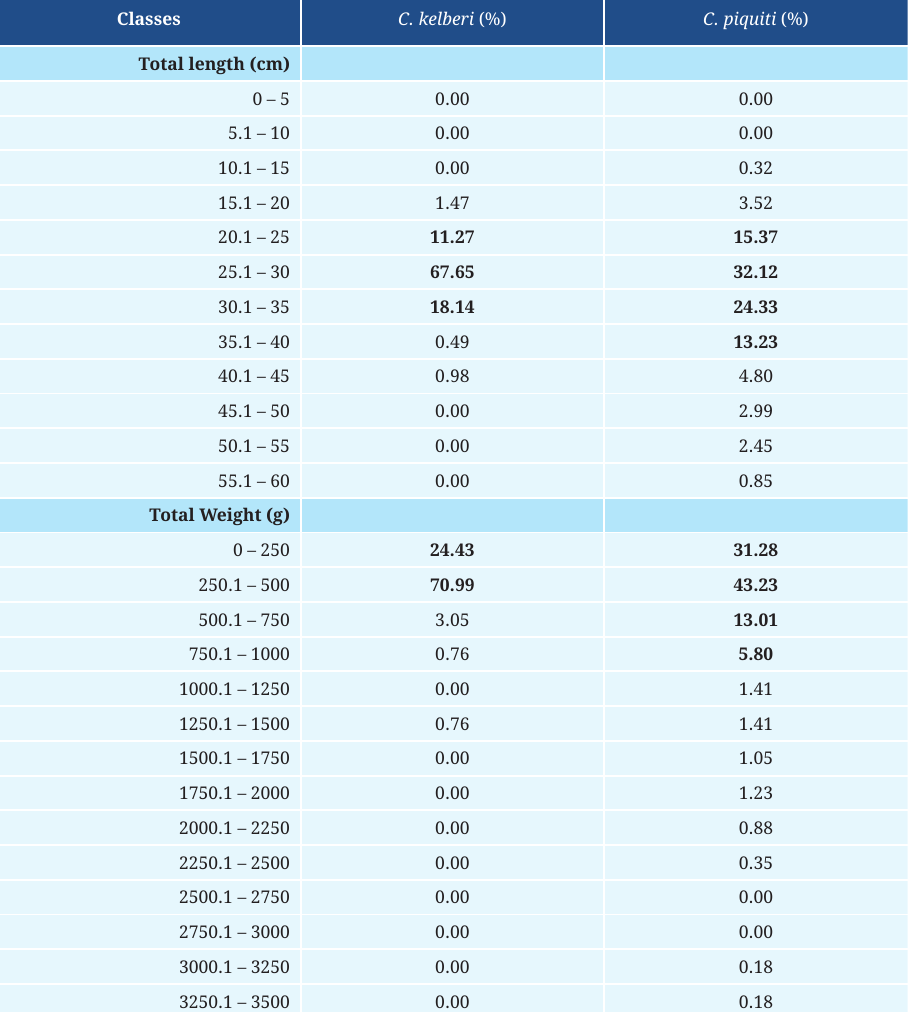
statistically clear difference in mean TL (ANOVA: Welch F = 94.0; p < 0.0001) and 1;1139 TW (ANOVA: Welch F = 35.81; p < 0.0001) between species, with higher values 1;699 for C. piquiti . Males predominated in both populations, with a mean proportion of 1:1.8 for C. kelberi and 1:1.4 for C. piquiti ; we observed no clear statistical difference in the sex ratio between species (ANOVA: F = 0.65; p < 0.4365). During the study period, we 1;11 recorded 35 shoals, totaling 72 fish captured. Of these, C. kelberi (5 fish) was present in 8.6 % of the shoals, while C. piquiti (66 fish) was present in 85.7%. Trophic ecology. We analyzed 40 stomachs of C. kelberi (12 resources consumed) and 251 of C. piquiti (23 resources). Teleost fish represented the main resource consumed, especially Cichlidae, Engraulidae, Serrasalmidae, and different Characiformes (Fig. 3A). Diet similarity between the species was 0.65 (Bray-Curtis). Accumulation curves did not stabilize, but both species consumed a similar number of resources considering a same TABLE 1 | Size distribution of Cichla kelberi and C. piquiti among classes of total length (cm) and total weight (g), based on the percentage of fish in each class. Bold indicate more frequent